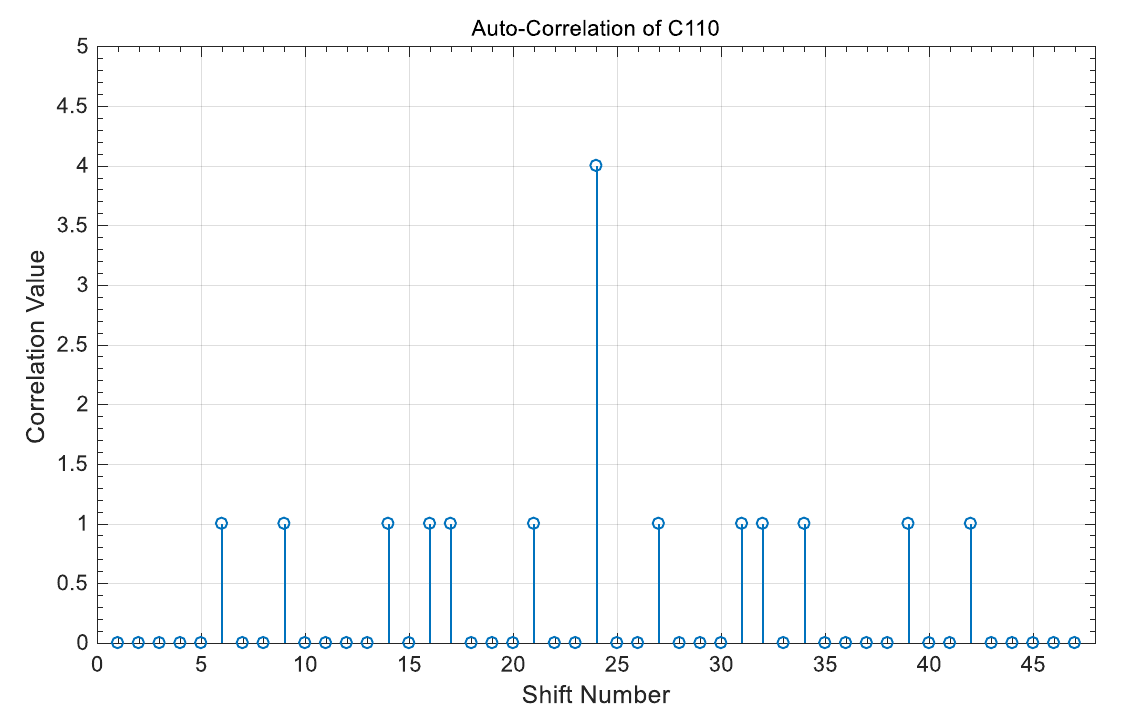
Figure 4. Auto-correlation of 𝐶 110 sequence, 𝑃 1 = 5 and 𝑃 2 = 7 .